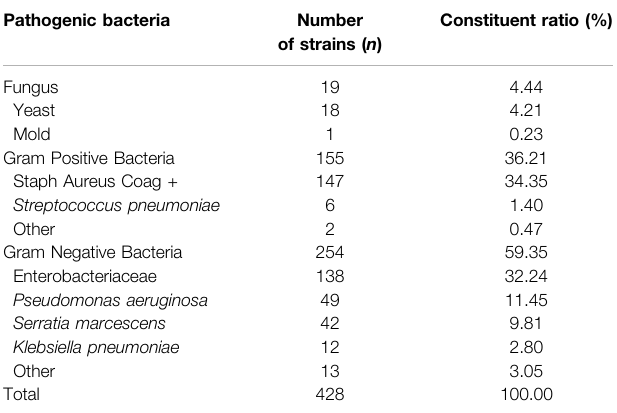
TABLE 3 | Types and composition ratio of main pathogenic bacteria in respiratory tract specimens of patients with VAP treated with fi rst-generation of cephalosporin combined with vancomycin.